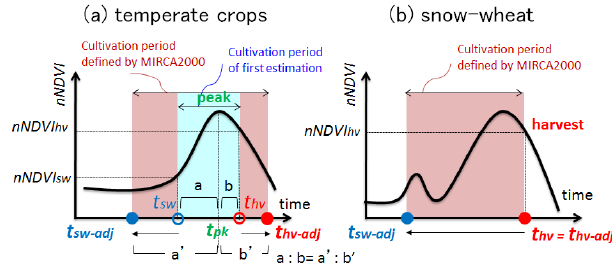
Figure 8. Scheme used to adjust the cultivation period of SACRA to that of MIRCA2000. t sw ( t hv ) and t sw − adj ( t hv − adj ) denote sow- ing (harvesting dates) for the first estimation and subsequent to the adjustment, respectively. For temperate crops, sowing and har- vesting dates are moved (advanced or postponed) to adjust the cultivation period to MIRCA2000. In this treatment, the ratio of t pk − t sw to t hv − t pk is preserved as the ratio of t pk − t sw − adj to t hv − adj − t pk . For snow-wheat, the harvesting date has not changed (i.e., t hv = t hv − adj ). Sowing date is determined by the cultivation period of MIRCA2000 and the harvesting date of the first estima-